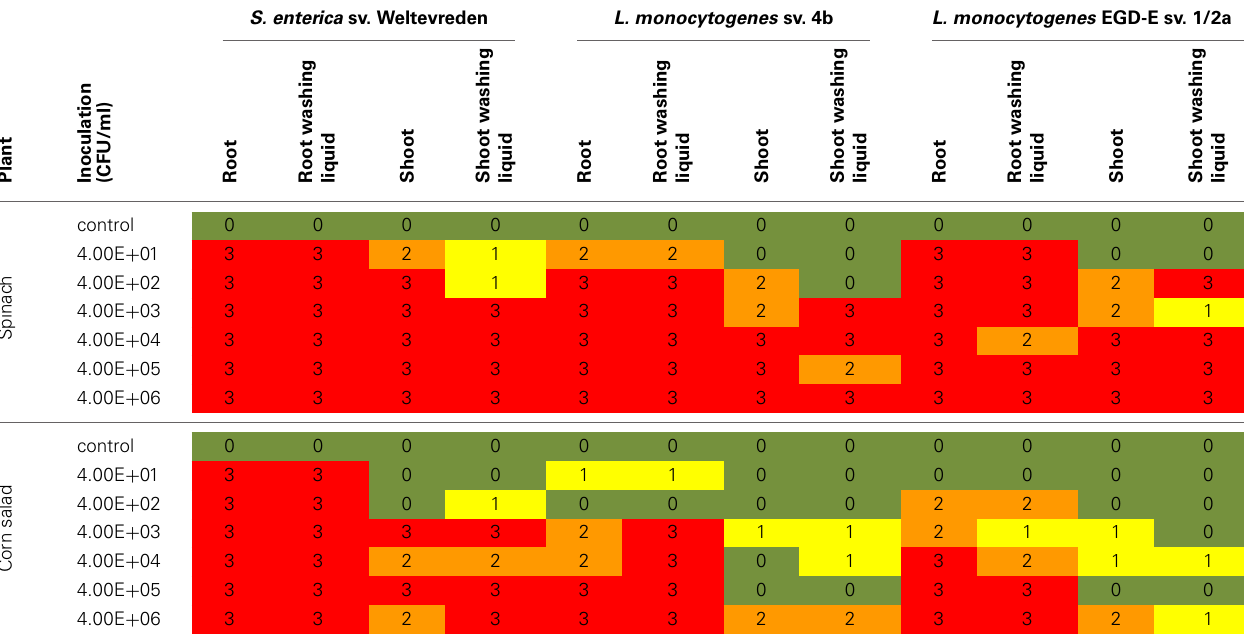
Table 1 | Results of the inoculation experiment in the axenic